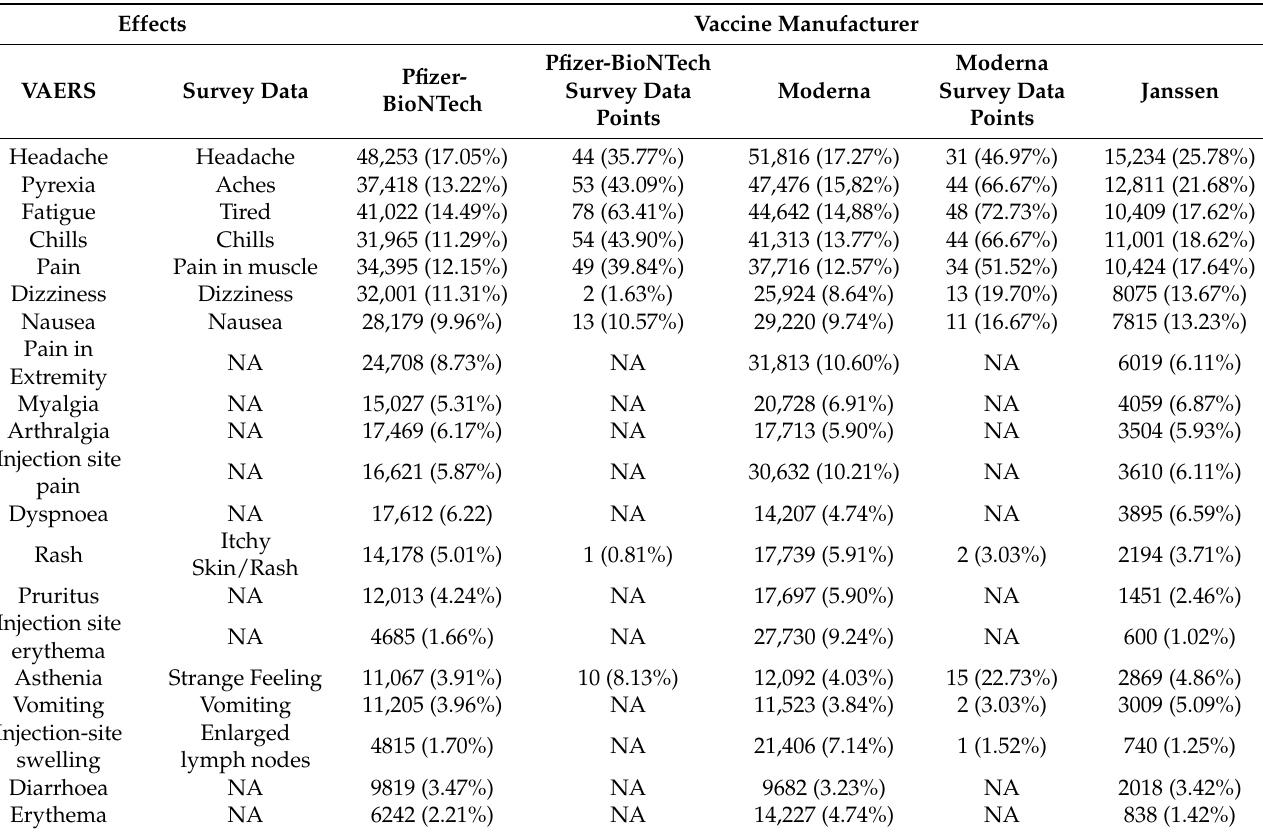
Table 1. Summary of the 20 most commonly reported AEs in VAERS reports and online survey data per three vaccine